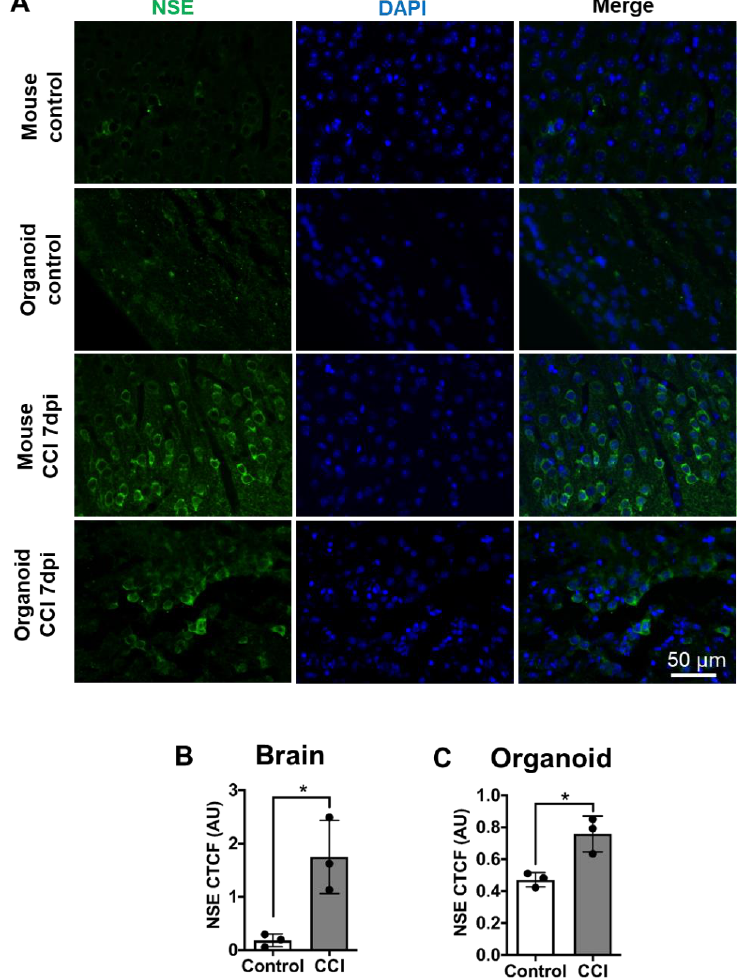
Figure 4. CCI induced neuronal damage in COs. ( A ) To analyze neuronal damage after CCI, mouse brain and COs slides were immunostained with NSE antibody. Images were analyzed using corrected total cellular fluorescence. ( B ) Significant increase in NSE staining in mouse brain after CCI compared to control. ( C ) Similarly, CCI in COs significantly increased NSE accumulation in cells compared to sham control, indicating neuronal damage. Statistical analysis performed with Student’s t -test, * p ≤